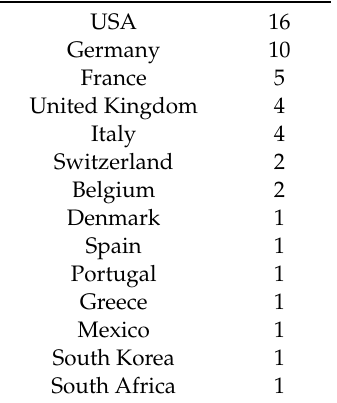
Table 2. Main location of the top 50 galleries participating to the 2019 edition of Art Basel in the “gallery”